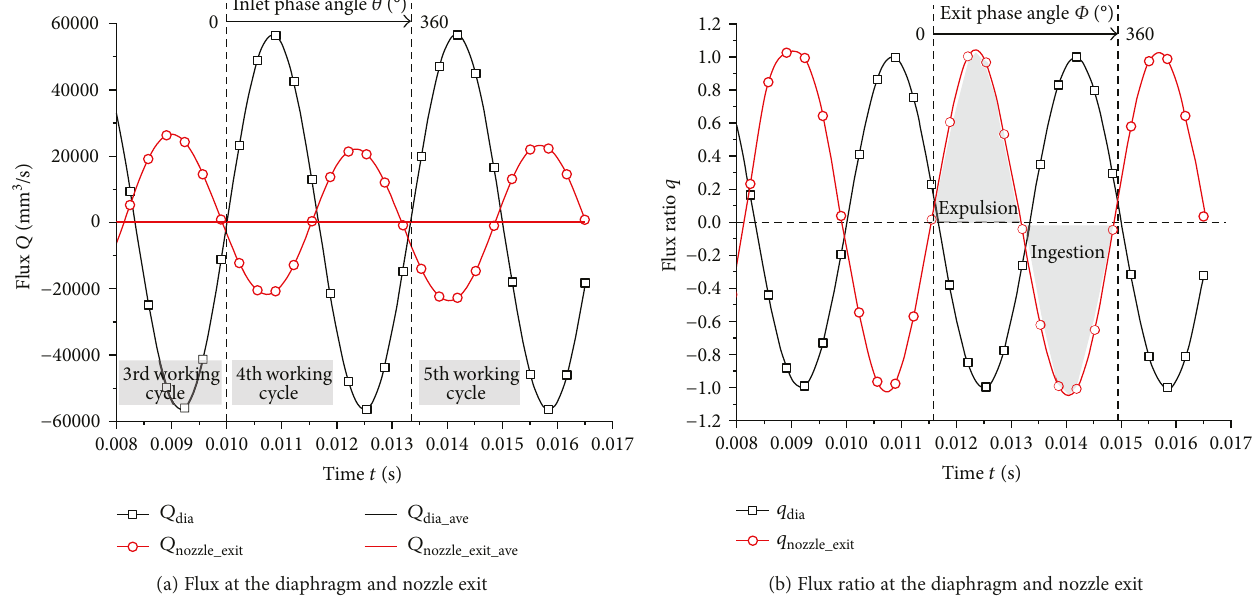
Figure 4: Physical fl ux and fl ux ratio at the diaphragm and nozzle exit from 3rd working cycle to 5th working cycle.